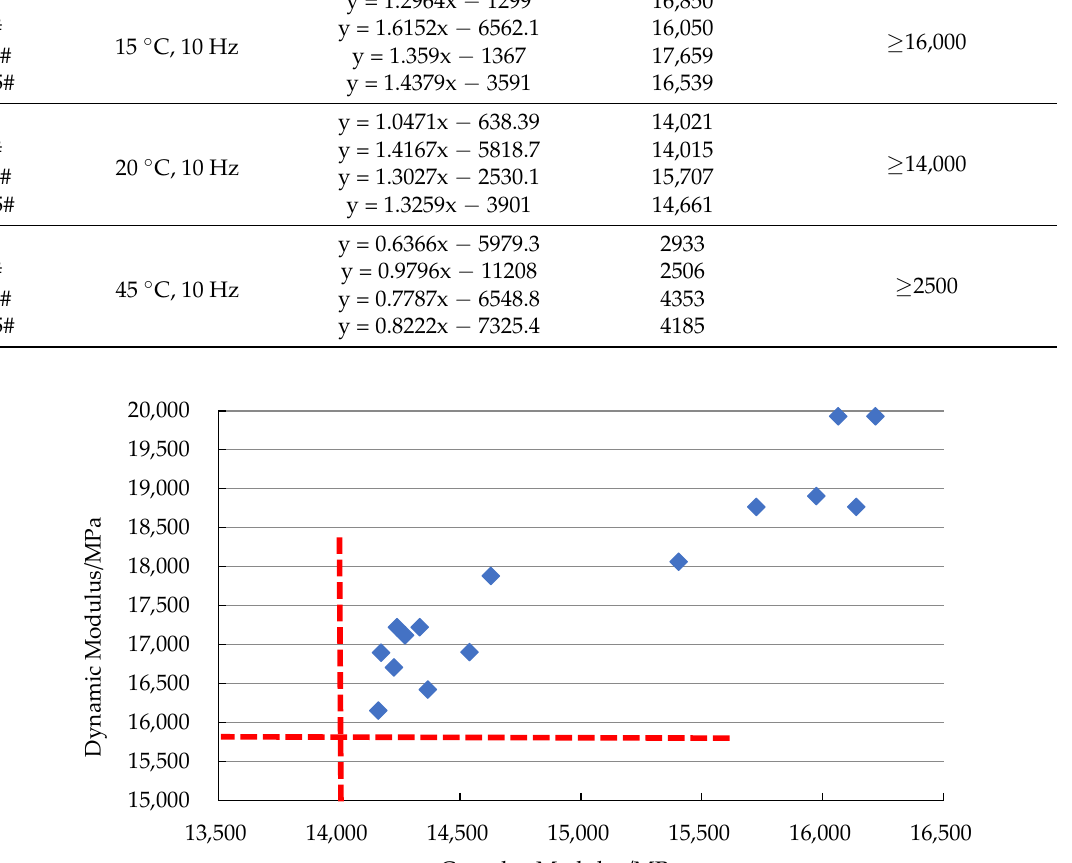
Figure 13. Corresponding relationship of modulus at 45 °C, 10 Hz.